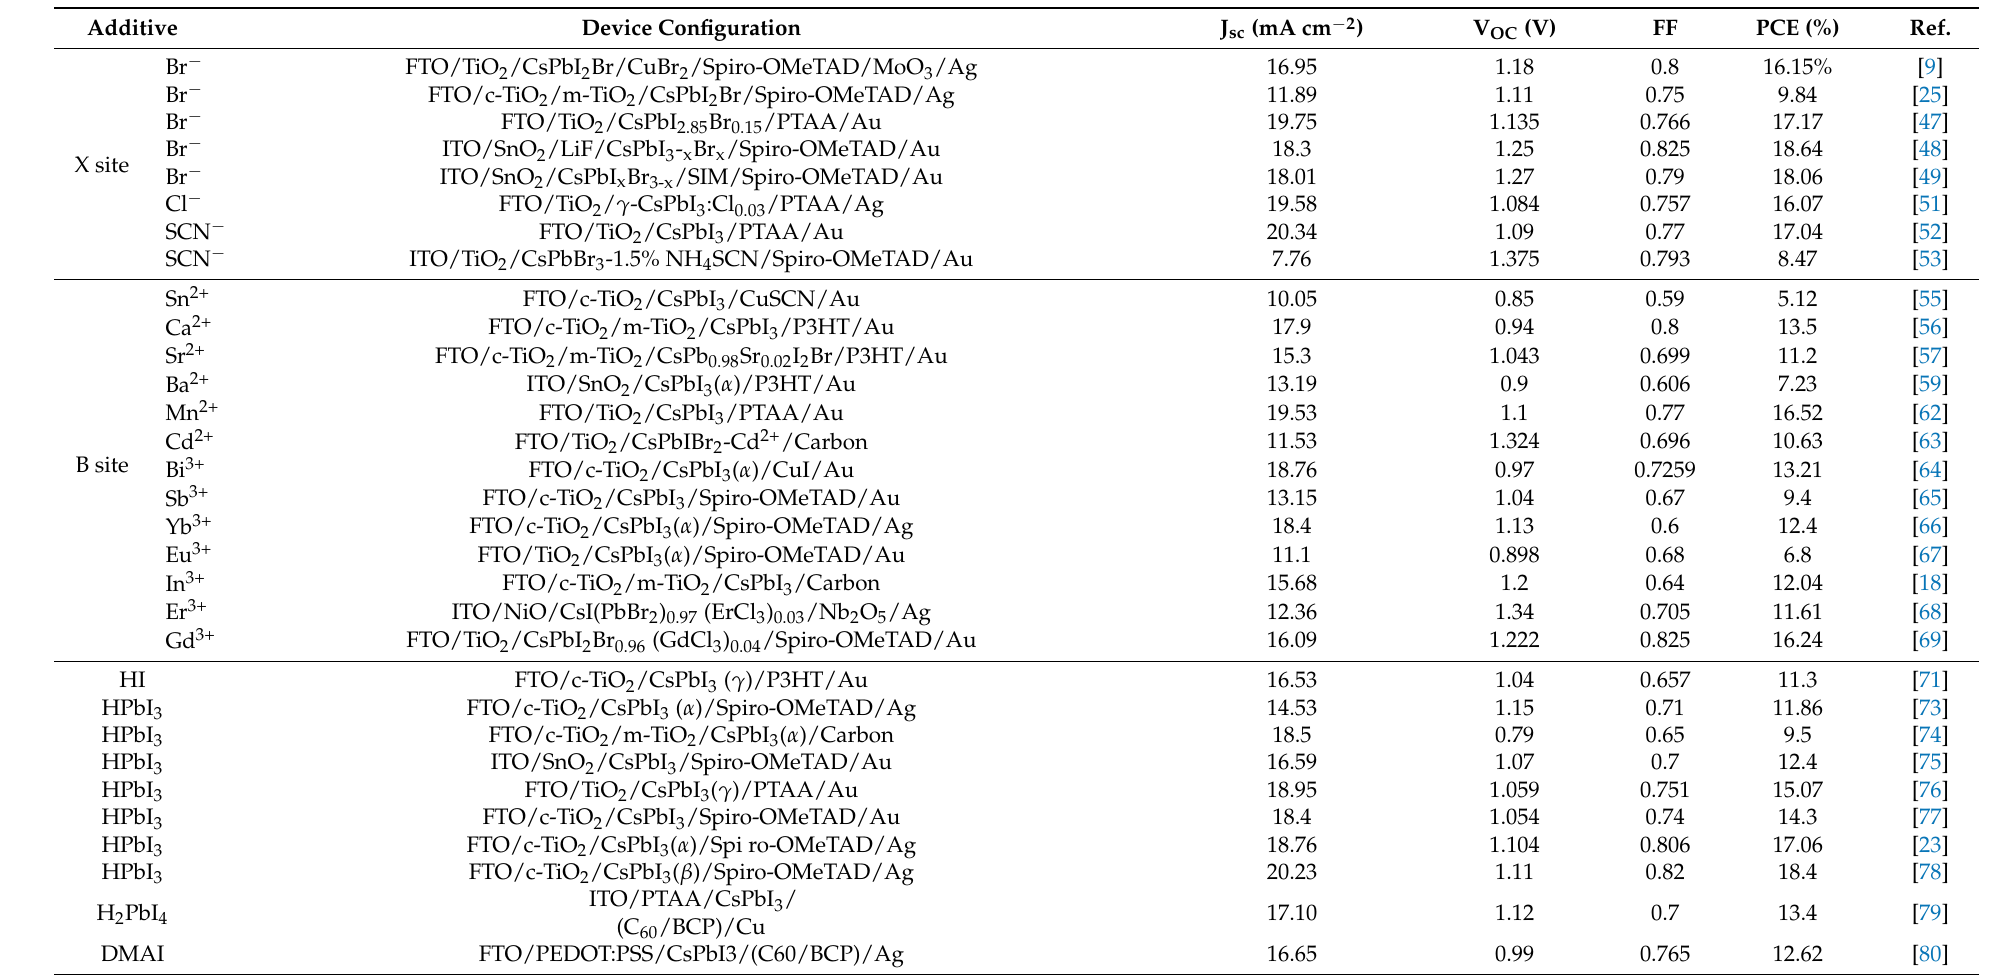
Table 1. Summary of various inorganic PSCs’ performance using additive